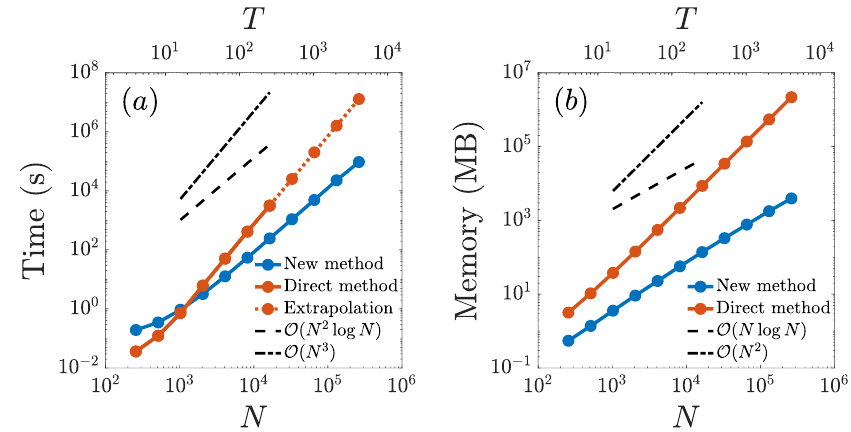
Figure 7: Increasing the propagation time T with N fixed time steps of size ∆ t and SVD truncation tolerance (cid:34) = 10 − 4 , for the Floquet example. The plots are analogous to those shown for the ramp example in Fig.